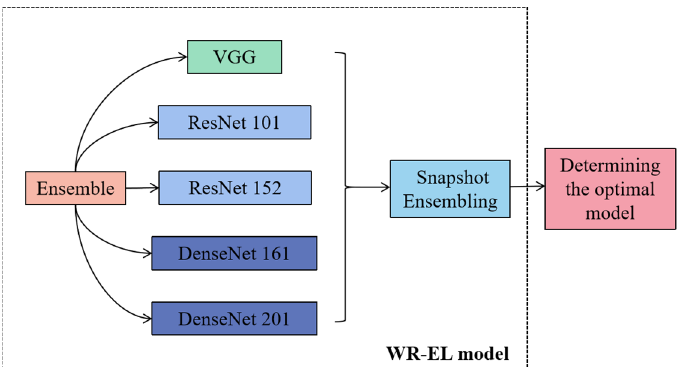
Figure 5. The WR-EL model structure.